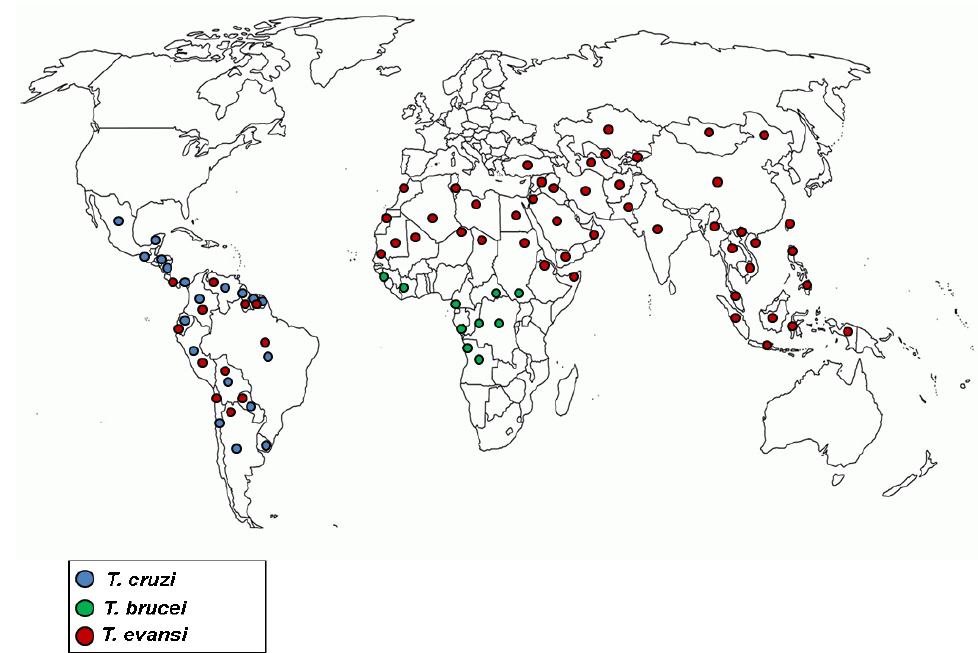
Figure 1. Worldwide distribution of the main species causing human trypanosomiasis.